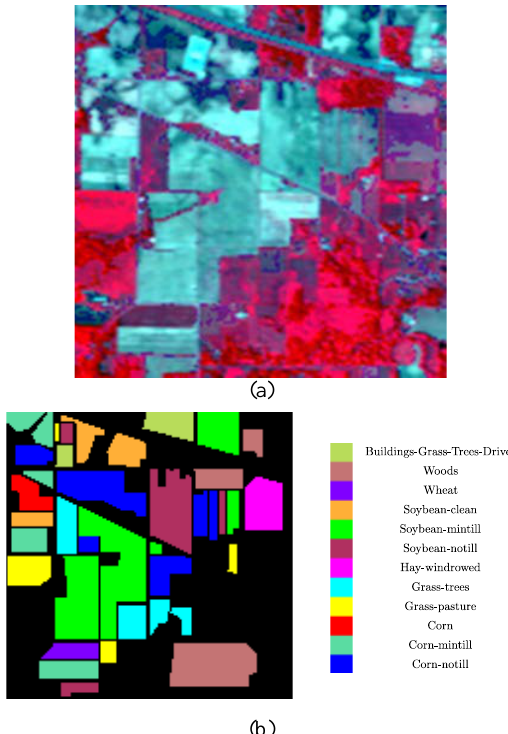
Figure 3. Indian Pine case study. (a) False color composite; (b) Ground truth map.